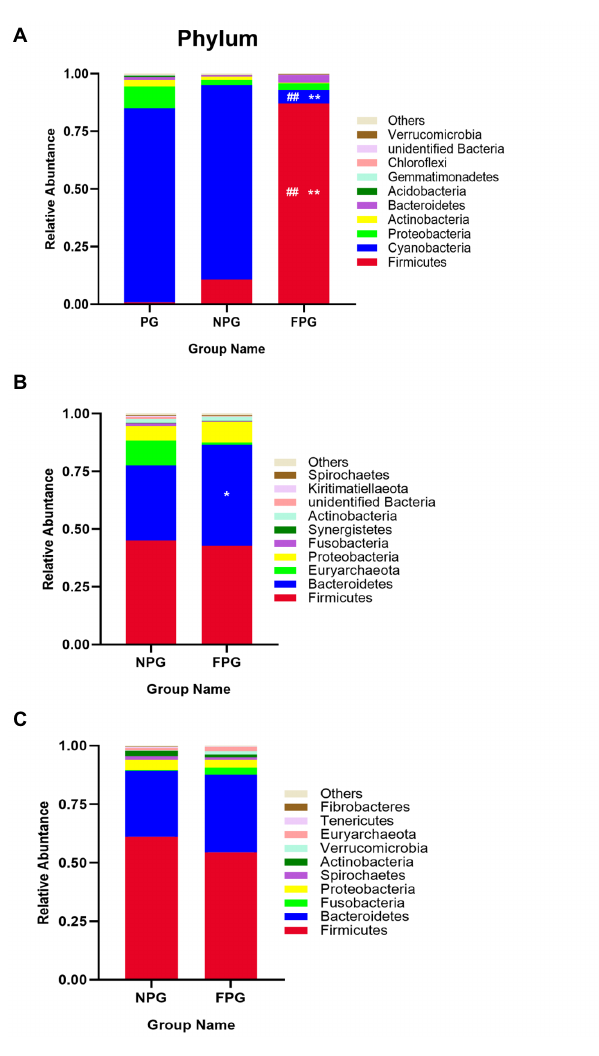
FIGURE 3 Histogram of the relative abundance of feed and gastrointestinal microbiota at the phylum (Left column) and genus (Right column) level. (A) Feed. (B) Rumen. (C) Caecum contents. Data are expressed as mean ± SD ( n = 3). # p < 0.05 and ## p < 0.01 compared with the PG group; * p < 0.05 and ** p < 0.01 compared with the NPG